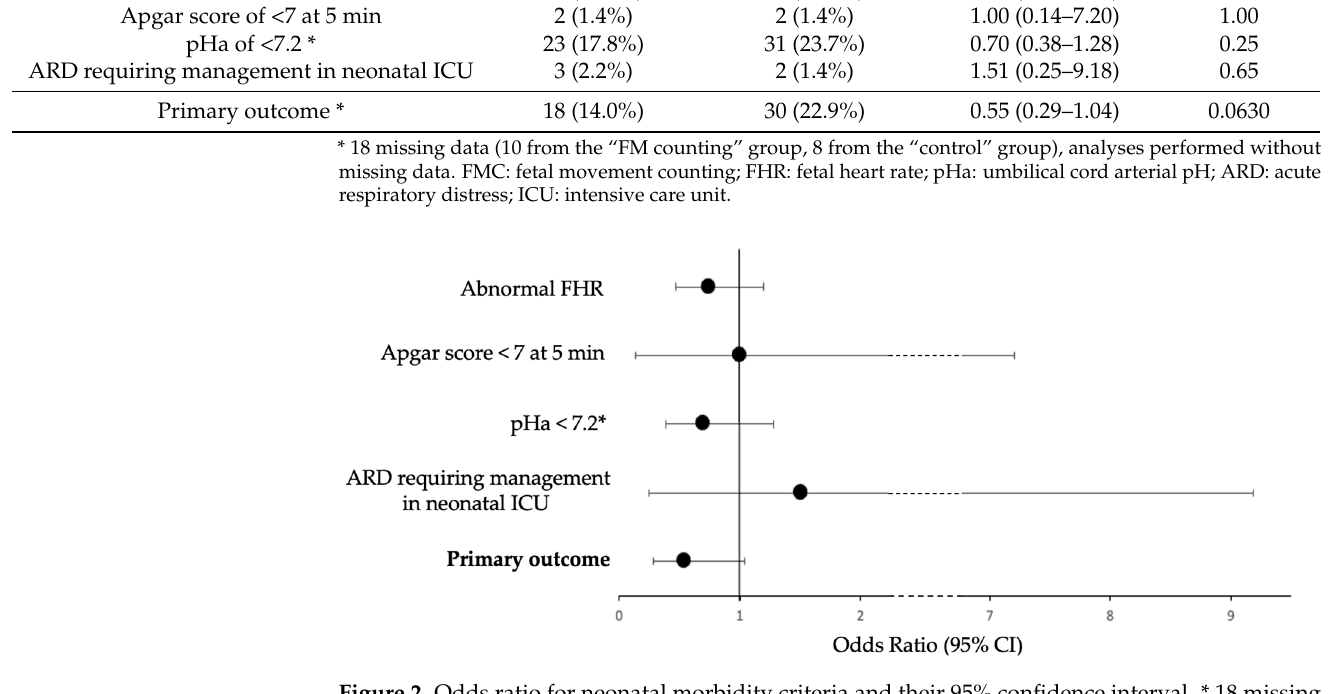
Figure 2. Odds ratio for neonatal morbidity criteria and their 95% confidence interval. * 18 missing data (10 from the “FM counting” group, 8 from the “control” group), analyses performed without missing data. FHR: fetal heart rate; pHa: umbilical cord arterial pH; ARD: acute respiratory distress; ICU: intensive care unit.